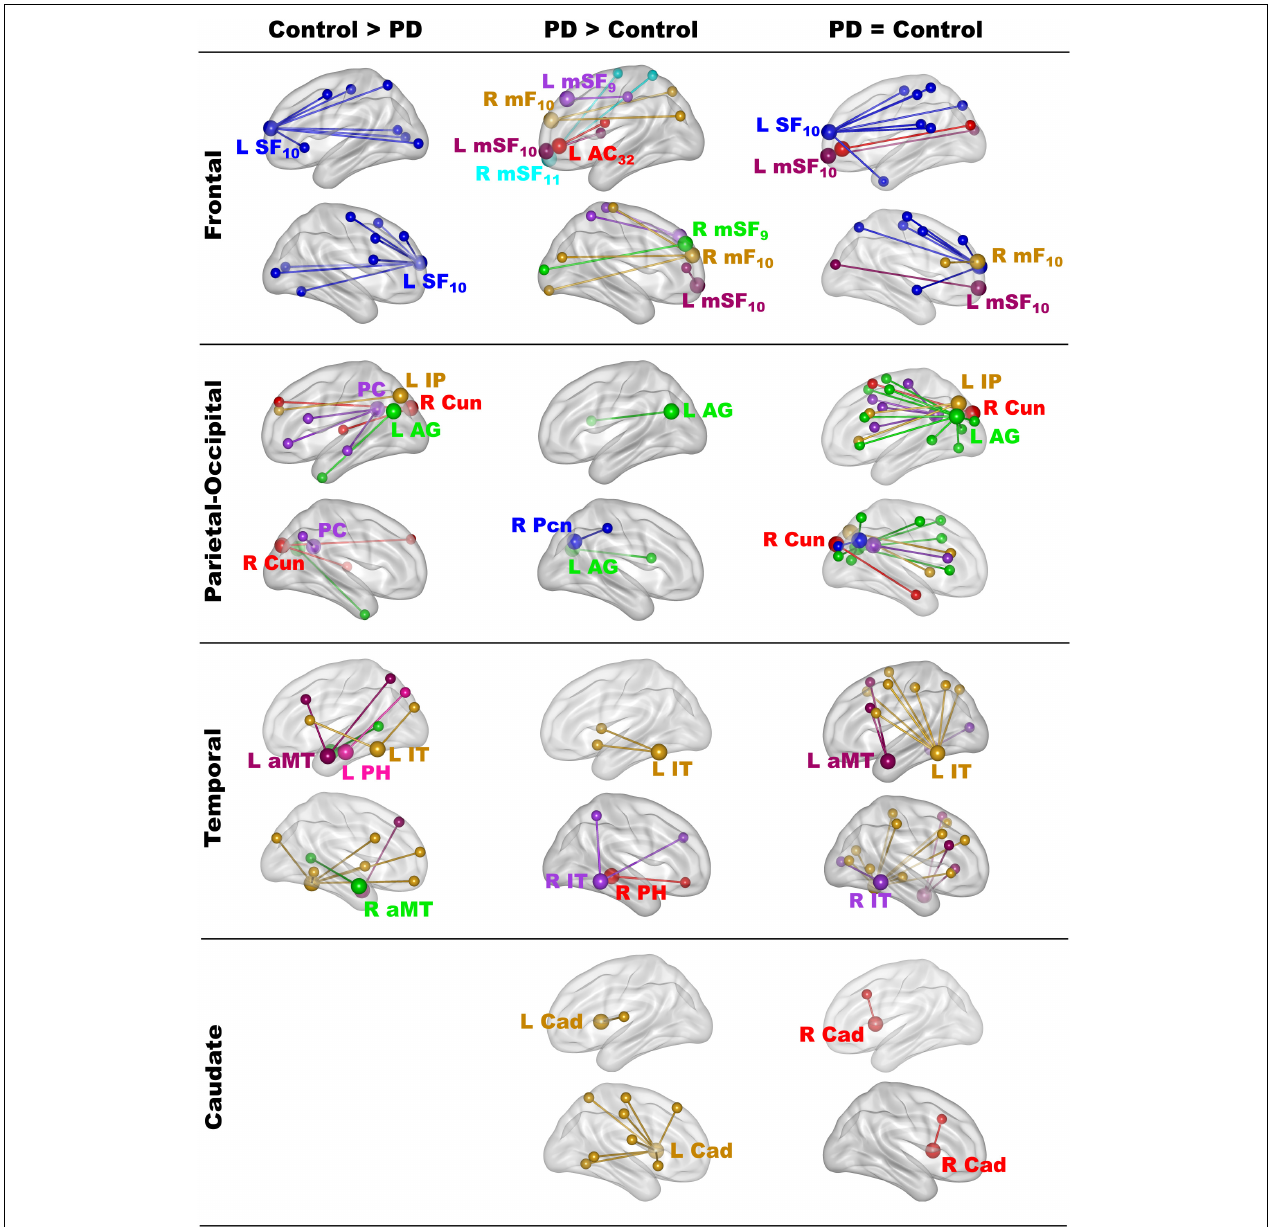
FIGURE 2 | Group differences in fame-modulated functional connectivity. The figure illustrates the connections of a seed ROI (large balls) with other brain regions (small balls) that were stronger for famous than unfamiliar names. Seeds and their connections are color coded and separated into frontal, parietal-cuneus, temporal, and subcortical loci. In one or both groups, famous name seed time-courses correlated more positively with the time courses of other brain voxels than unfamiliar name seed time-courses. Columns display seed connections that were stronger in the control (Control > PD) or the PD group (PD > Control). The right column shows seed connections for which the strength of fame-modulated connectivity did not differ between groups (PD = Control). Supplementary Tables 4–6 detail the volumes and spatial coordinates of connectivity features, and the p values for tests of group differences in connectivity features. L, left hemisphere; R, right hemisphere; Brodmann areas are designated by subscripts. AC, anterior cingulate; AG, angular gyrus; aMT, anterior middle temporal; Cad, caudate; Cun, cuneus; IP, inferior parietal; IT, inferior temporal; mF, medial frontal; mSF, medial superior frontal; Pcn, precuneus; PC, posterior cingulate; PH, parahippocampus; SF, superior